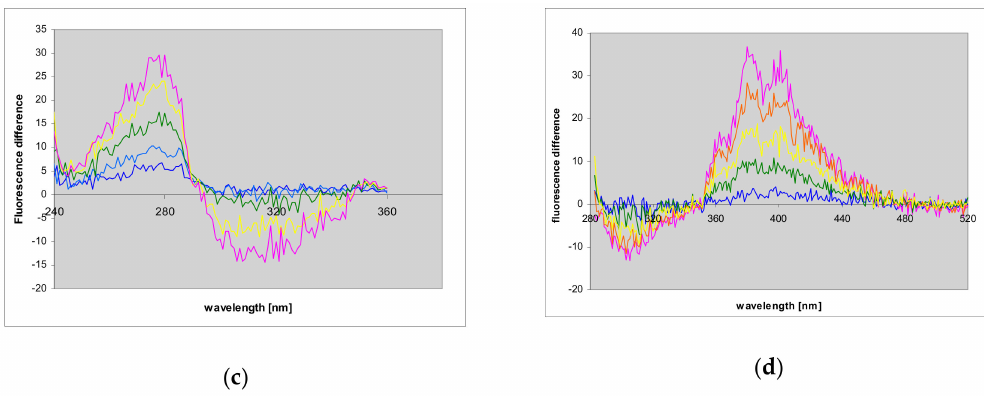
Figure 10. Changes in fluorescence excitation ( a ) and emission spectra ( b ), observed during the titration of E. coli PNP with N 2 ,3-etheno-2-aminopurine ( 2 ). The excitation spectra were observed at 390 nm, and for emission spectra excitation was at 280 nm. Spectra of the free ligand (3.5 µ M) are given for comparison (points). Excitation spectrum of the protein, monitored at 310 nm, is given in black. Conditions: 40 mM phosphate, pH 7, at 20 ◦ C. Concentration of protein was 10.1 µ M (per subunit); that of the titrant was 0 to 3.5 µ M. Lower panels: Fluorescence di ff erence spectra, calculated from data